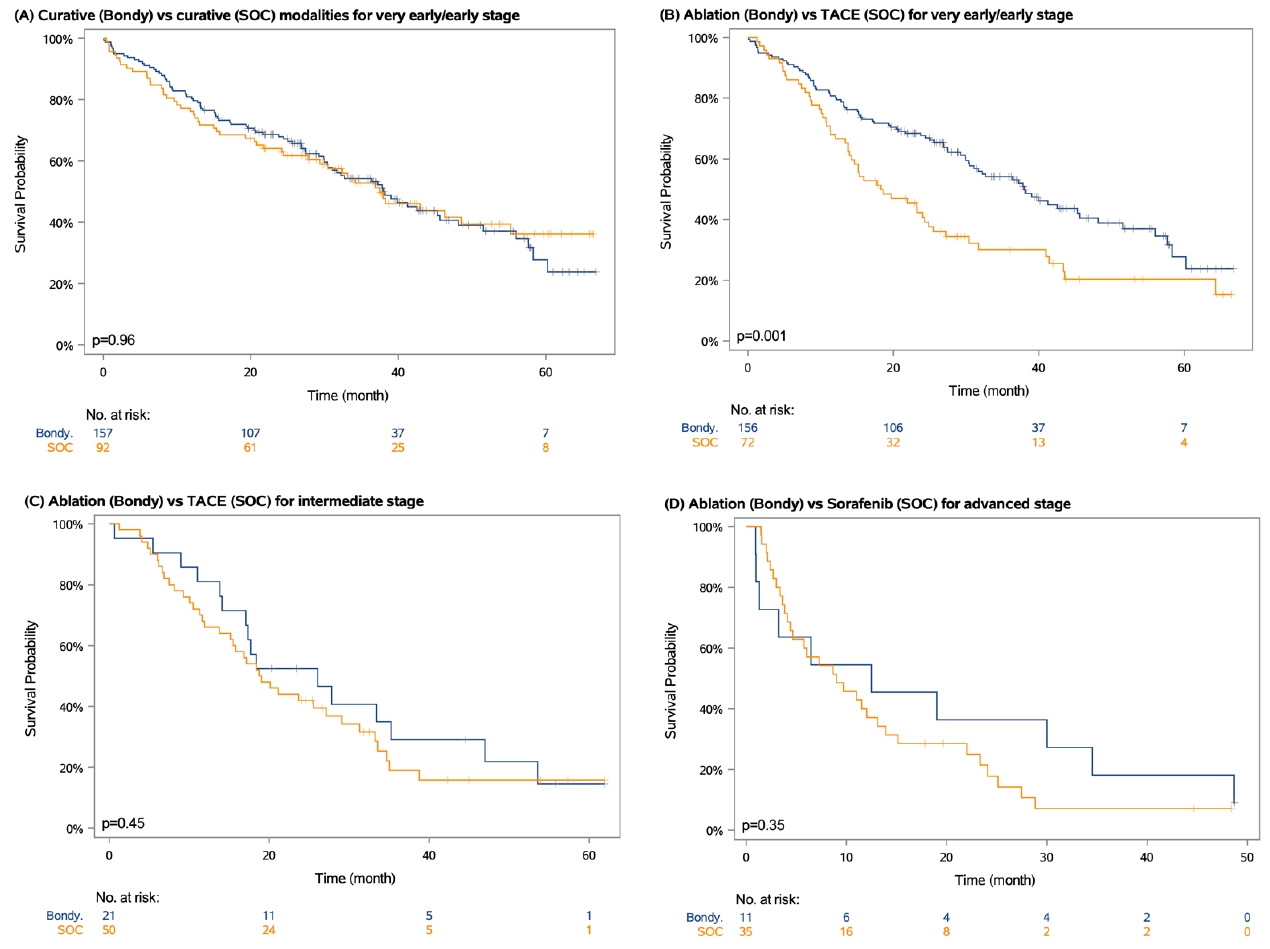
Figure 5. Kapan–Meier survival estimates by BCLC stage and first-line treatment. ( A ) very early/early HCC treated with by first-line curative options, ( B ) very early/early HCC treated with first-line ablation in the Bondy group versus first-line TACE in the standard of care group, ( C ) intermediate Child A HCC treated with first-line ablation in the Bondy group versus first-line TACE in the SOC group and ( D ) advanced HCC treated with first-line ablation in the Bondy group versus Sorafenib in the SOC group.